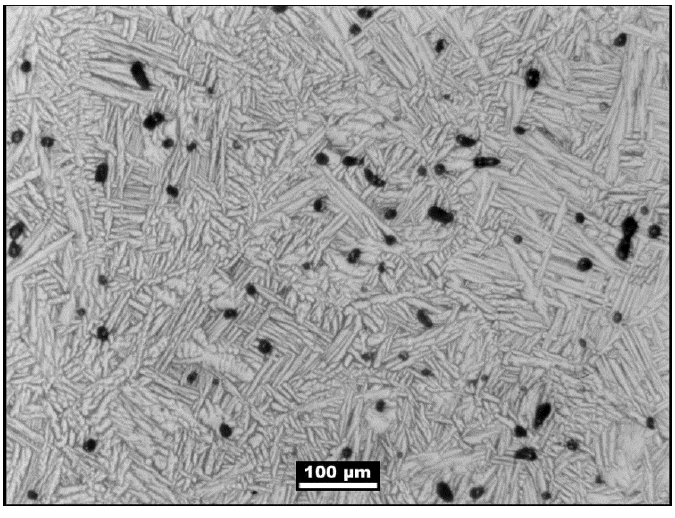
Figure 5. Microstructure for Ti-6Al-4V produced by Ti-MIM prior to hot isostatic pressing